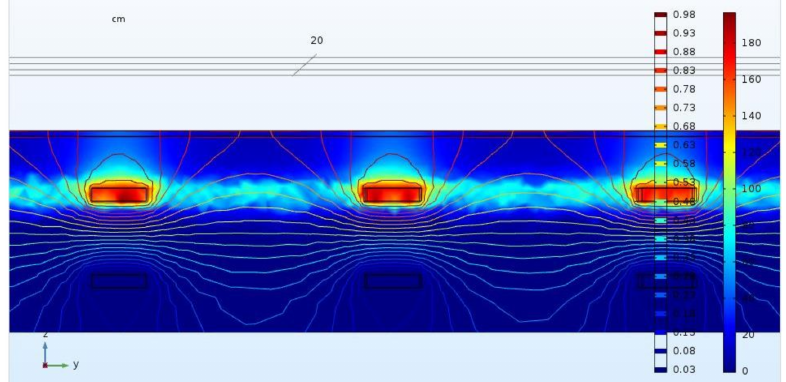
Figure 14. A 2D cut of the FEM solution for the NaCl concentration at 1 V and t = 650 d showing potential lines.